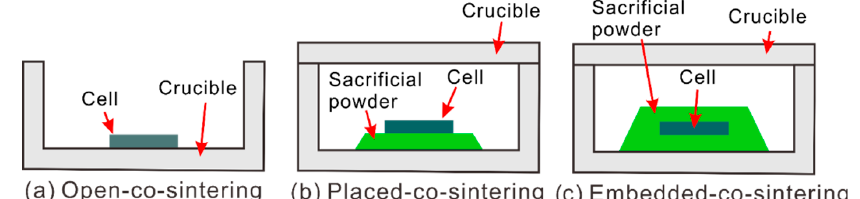
Figure 1. Schematics of ( a ) open-co-sintering, ( b ) placed-co-sintering, and ( c ) embedded-co-sintering methods used in this work. MgO crucibles were used in the experiments. For the placed-co-sintering and embedded-co-sintering methods, the half cells were placed on and embedded in the sacrificial powder of BZY20-1 wt % BaCO 3 , respectively.